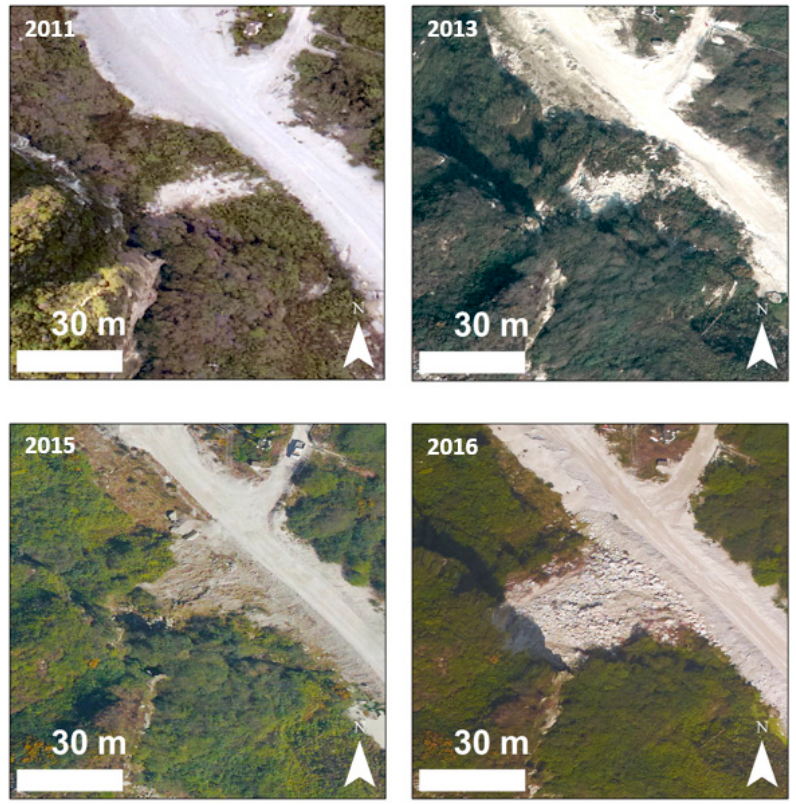
Figure 5. Orthorectified aerial imagery of the rockfall area. The sequence shows the activity of the rockfall, from its initial condition ( top left ), to the development of the rockfall at the whole slope scale in 2013 ( top right ), and the subsequent maintenance operations, the emplacement of the rock trap and the removal of rock fragments from the ditch. The last picture shows the aftermath of the major collapse that led to the actual slope geometry.